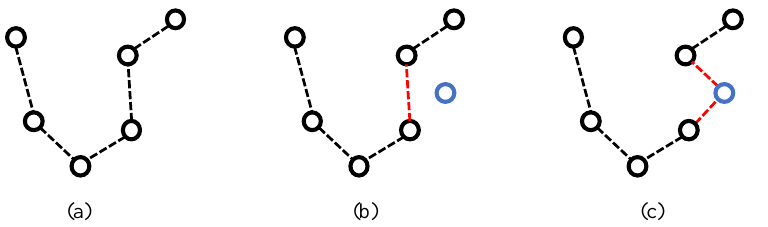
Figure 4. This is the progress of the proposed k-opt algorithm. The circle indicates the location of the ordered item, and the dotted line indicates the edge from one item to another. The blue circle is the location of the newly added order, and the red dotted line is the edge twisted by the newly added order. ( a ) Optimal path generated by using the given order position. ( b ) The new order is assigned. ( c ) The result of proposed